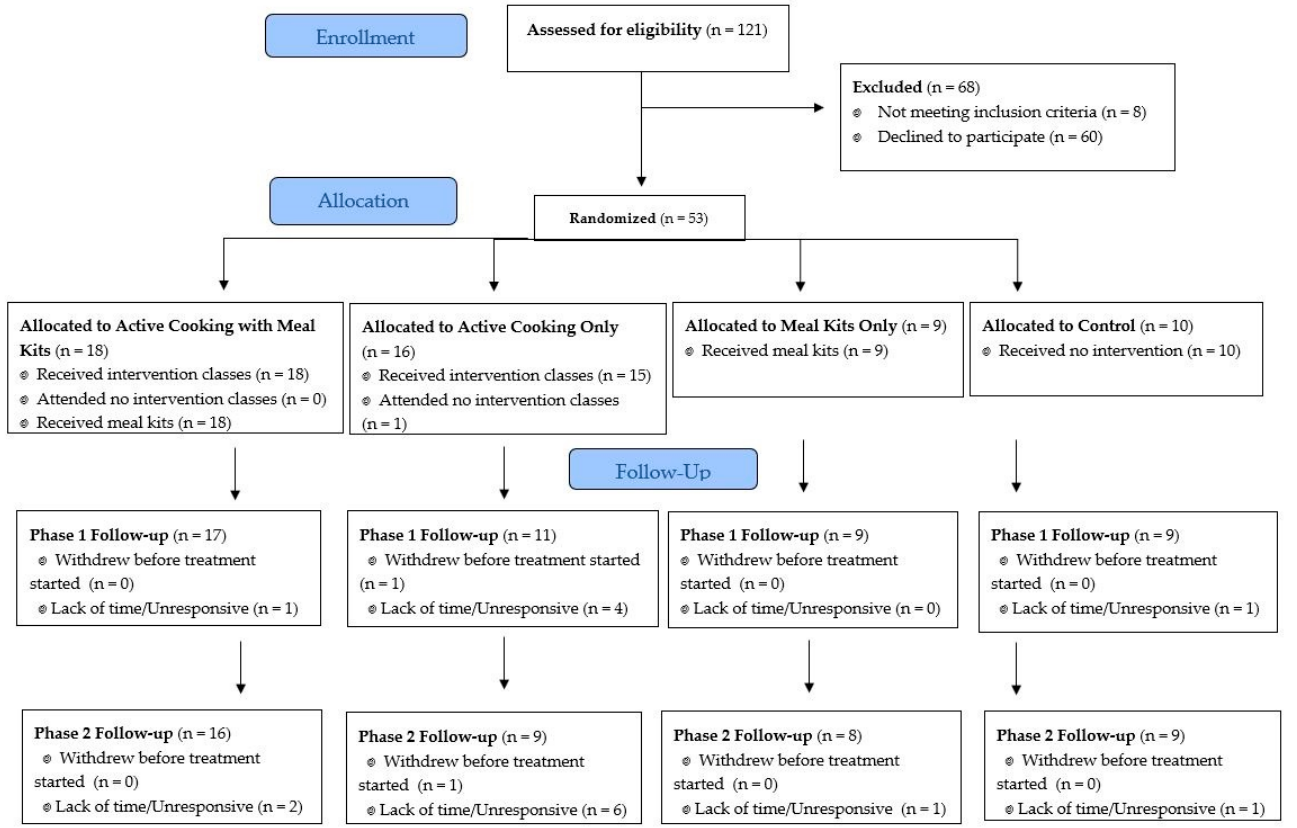
Figure 1. Consort flow diagram